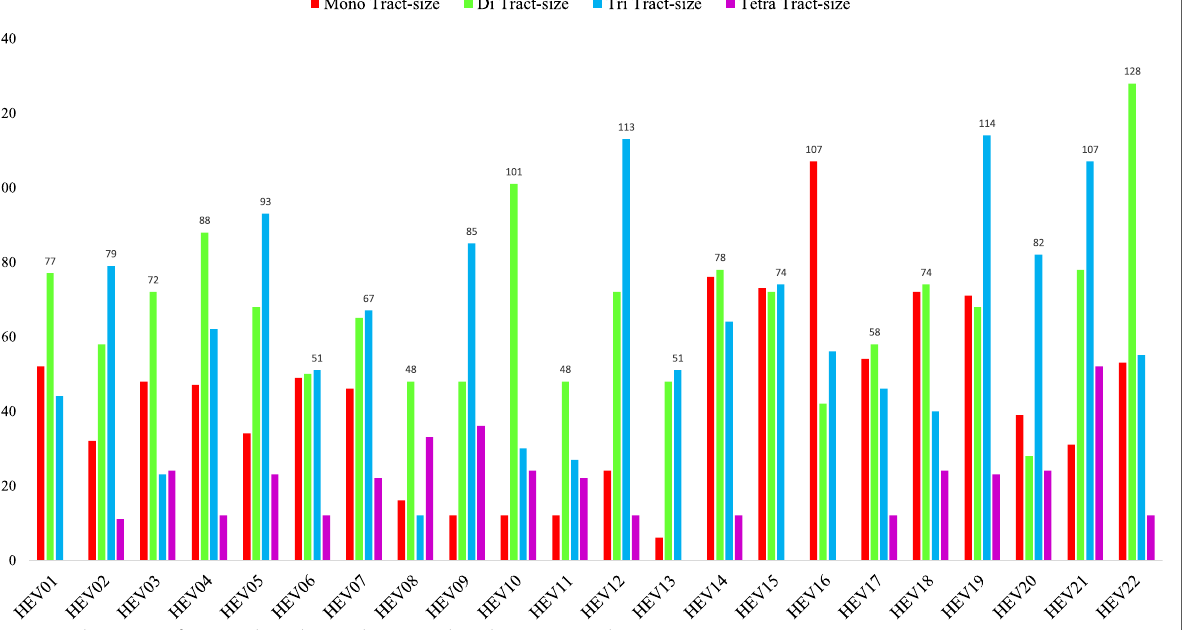
Fig. 2 Total tract size of mono-, di- and tri- and tetra- nucleotides in Hepeviridae